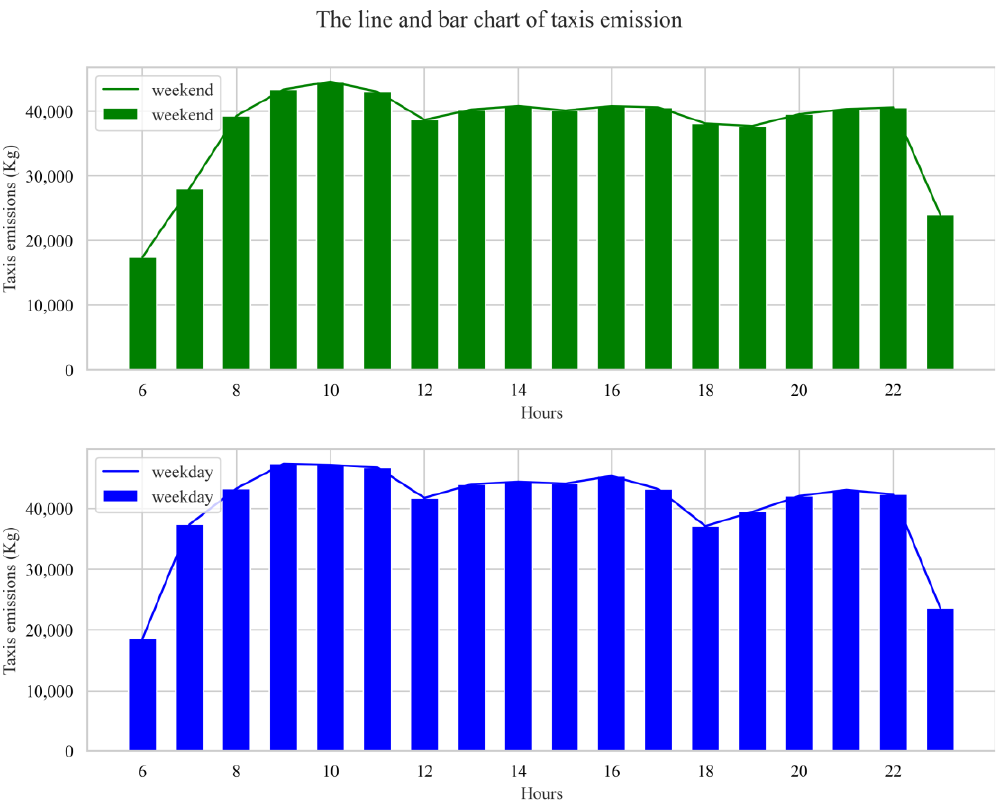
Figure 3. Hourly emission characteristics between 6:00 am and 23:00 pm.